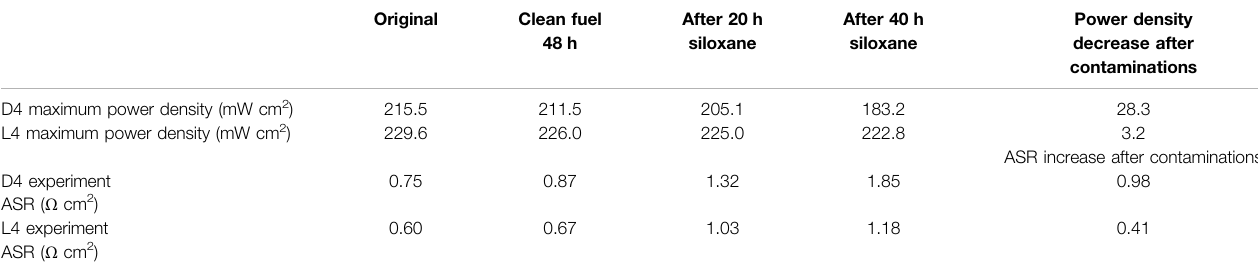
TABLE 2 | Maximum power density decrease and increase in area speci fi c resistance (ASR) calculated from characterization